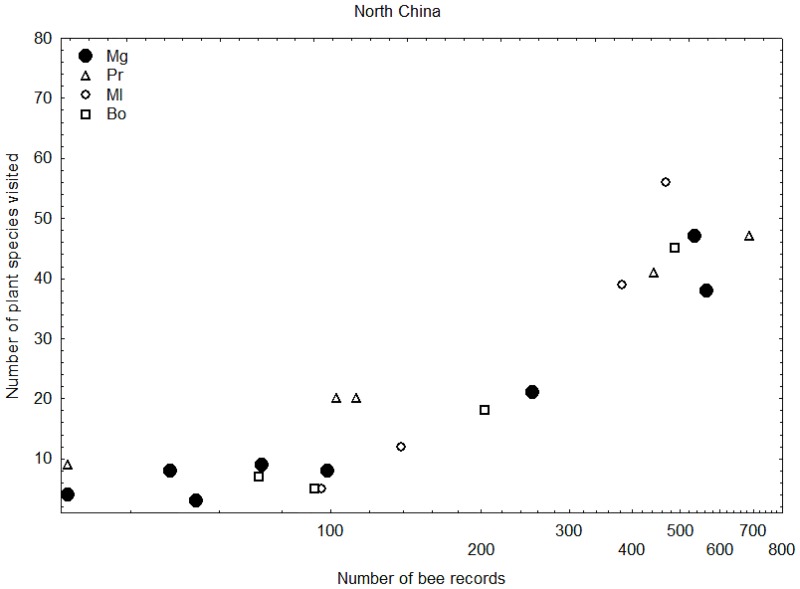
Relationship of number of food-plant species recorded per bumblebee species to number of bee records per bumblebee species.For species of the subgenera Megabombus (black spots), Pyrobombus (triangles), Melanobombus (circles), and Bombus s. str. (squares). Species with few food-plant-species records relative to the number of bee records are interpreted as more specialised in their fewer food-plant choices (Data from North China [14]).